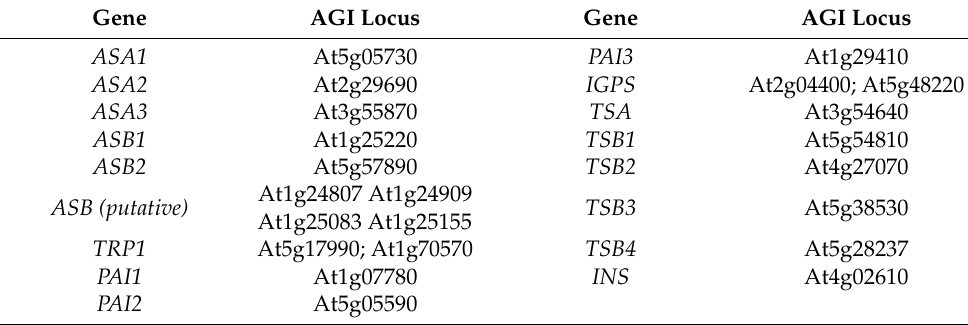
Table 1. List of genes reported to have an important role in the indole and trp synthesis. ASA, anthranilate synthase A; ASB, anthranilate synthase B; TRP, phosphoribosyl anthranilate transferase; PAI, phosphoribosyl anthranilate isomerase; IGPS, indole-3-glycerol phosphate synthase; TSA, tryp- tophan synthase A; TSB, tryptophan synthase B, INS; indole synthase. Gene AGI Locus Gene AGI Locus